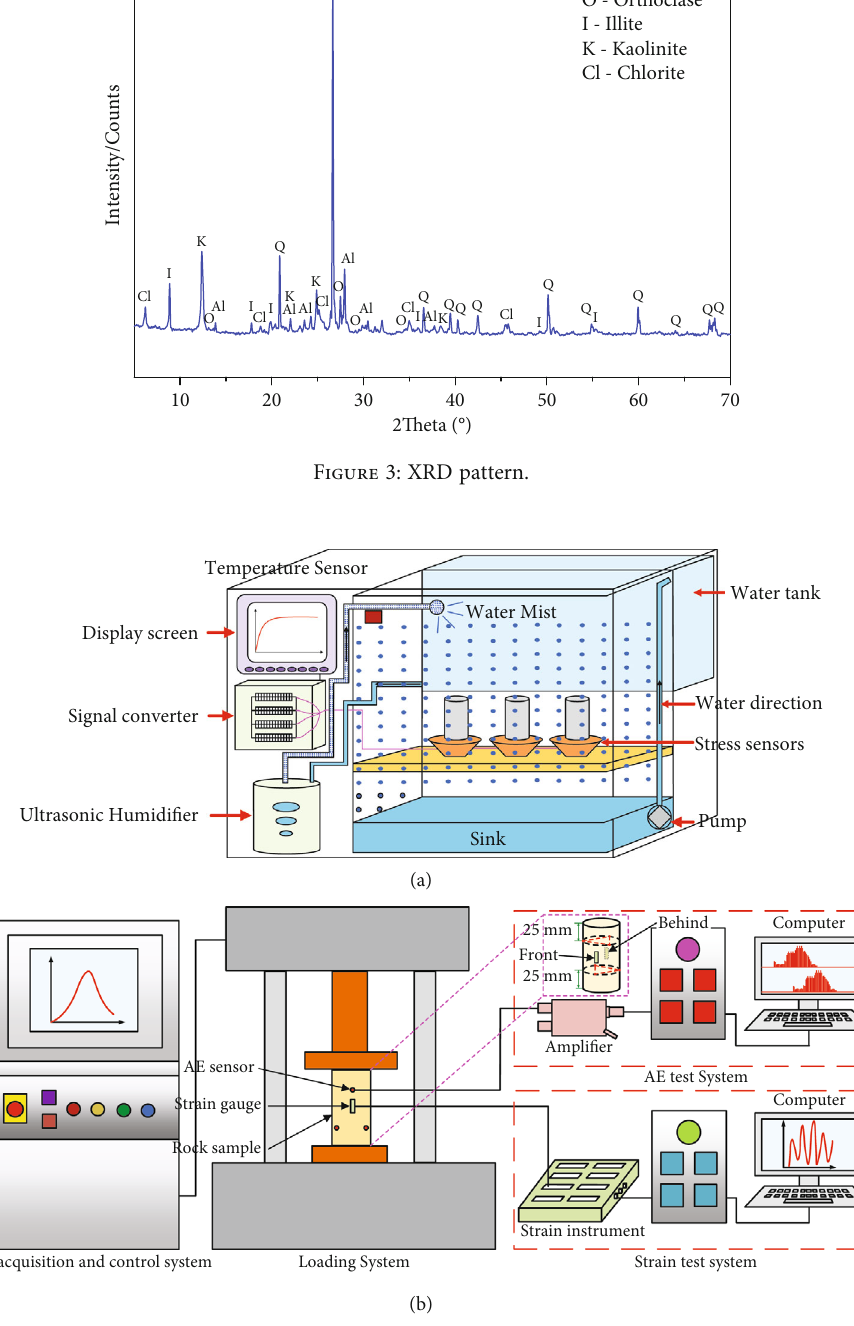
Figure 4: Test system. (a) ANDWID and (b) loading and monitoring